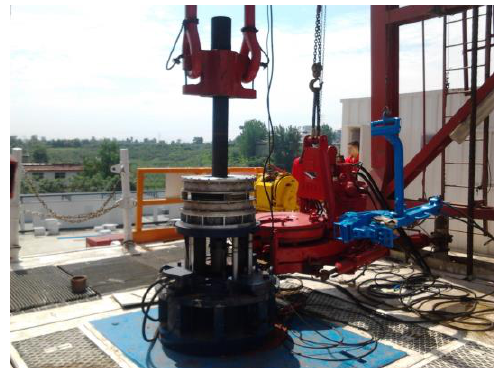
Figure 15. The whole MFL testing apparatus at the wellhead.